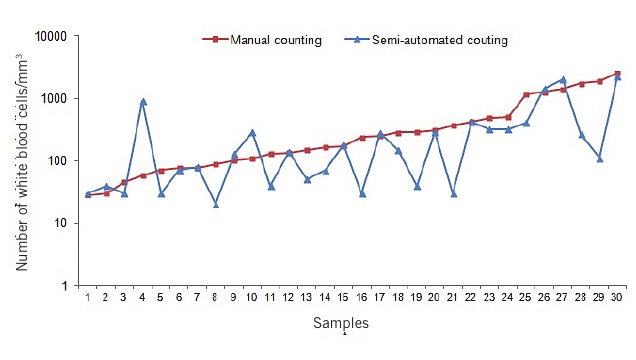
figuRE 1 − Comparison between manual (Fuchs-Rosenthal chamber) and semi- automated white blood cells count in peritoneal fluid